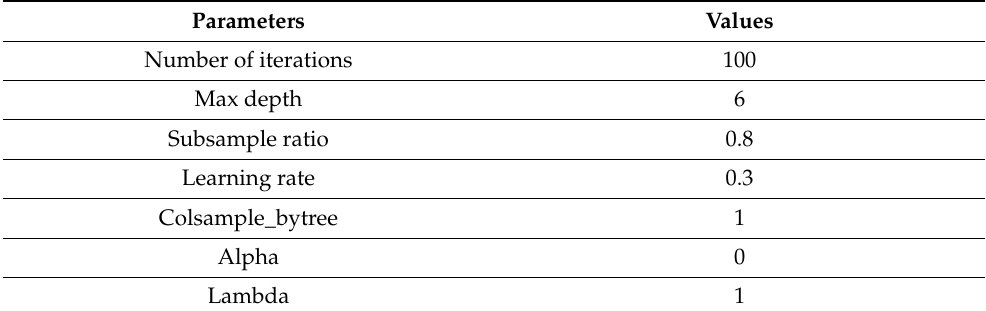
Table 4. Hyperparameter tuning of XGBoost